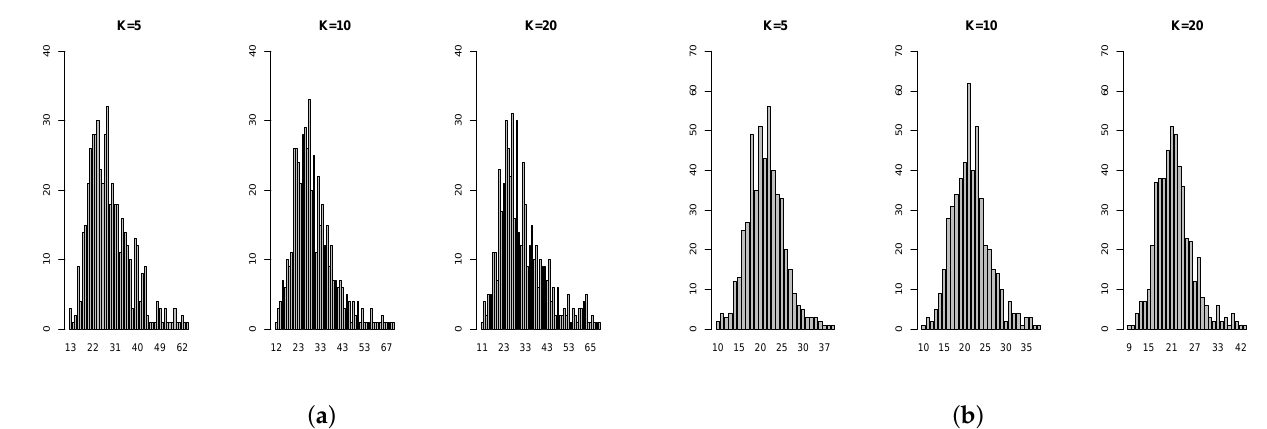
Figure A5. Bardet–Biedl data: | S (cid:53) ˆ S | ; S = var min , ( a ) ˆ S = var min ; ( b ) ˆ S = var 1 se